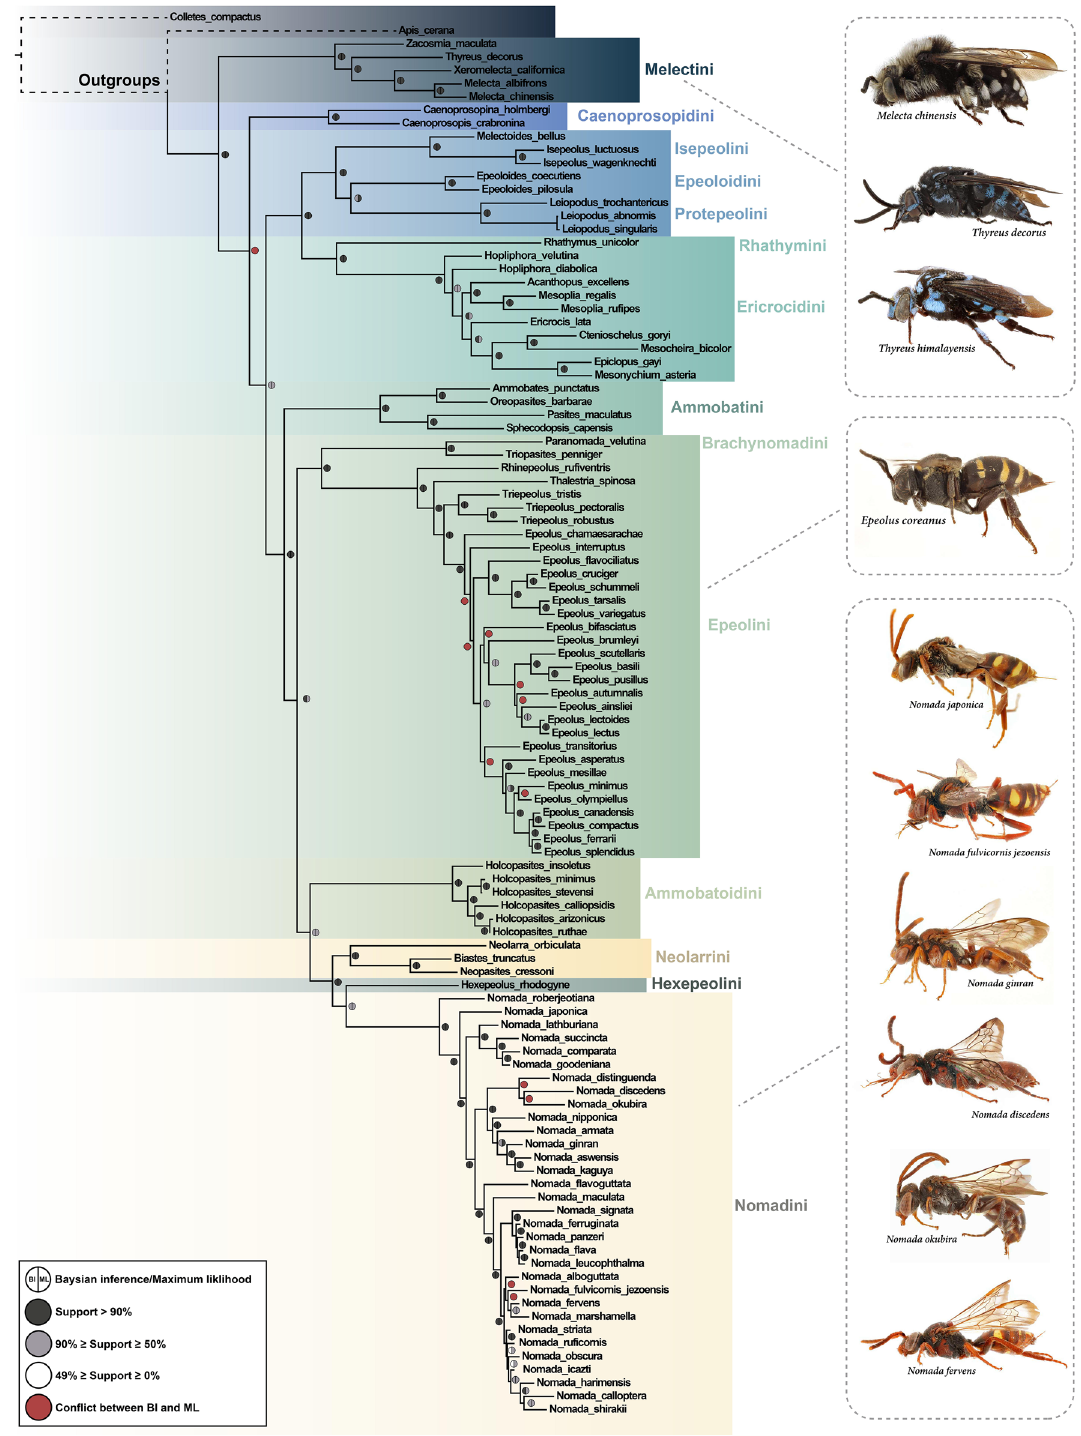
Figure 1. Combined Phylogenetic tree of Nomadinae. Produced with MrBayes. Colors of circles on the node indicate bootstrap supporting values, and the one topological difference between BI and ML trees is presented as a red circle. The tribal classification followed 31 . Habitus images of cuckoo bees was conducted by the first author, Kayun